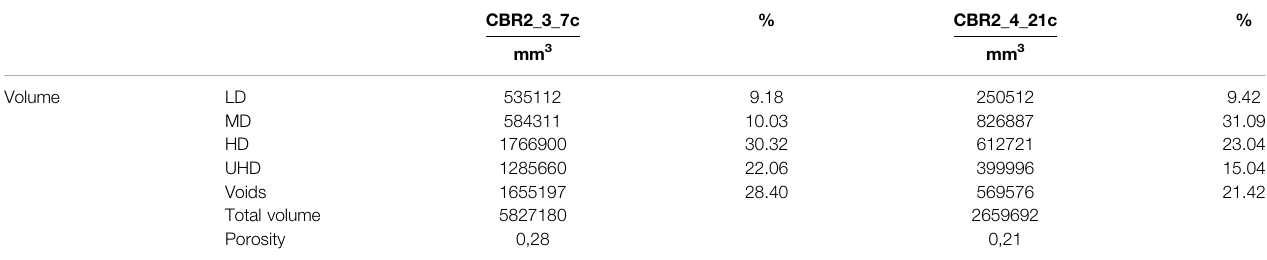
TABLE 2 | Results of the fragmentation in density classes from the CT analysis. Volumes in mm 3 and percentage. LD, low-density; MD, medium-density; HD, high-density; UHD,